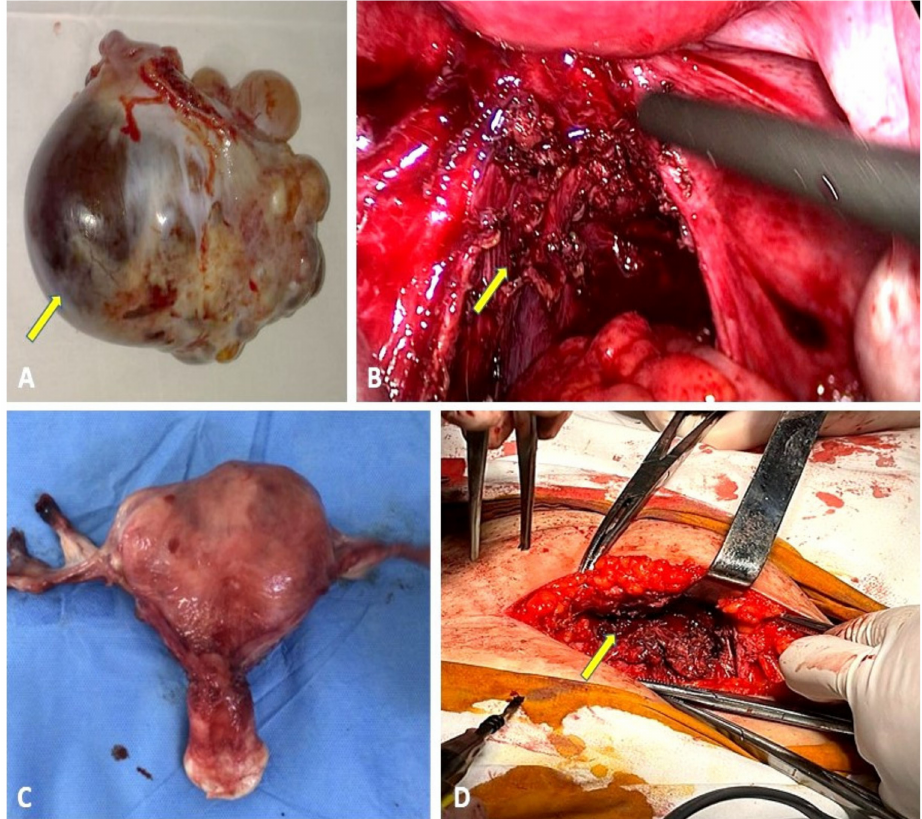
Figure 1. ( A – D )—Intraoperative and postoperative aspects of endometriosis with different locations. ( A ) Surgically excised ovary with multiple endometriotic cysts; ( B ) laparoscopic imaging of deep infiltrating endometriosis; ( C ) severe clinical presentation of adenomyosis, uterus extracted by total hysterectomy with bilateral adnexectomy procedure; and ( D ) abdominal wall endometrioma within a cesarean